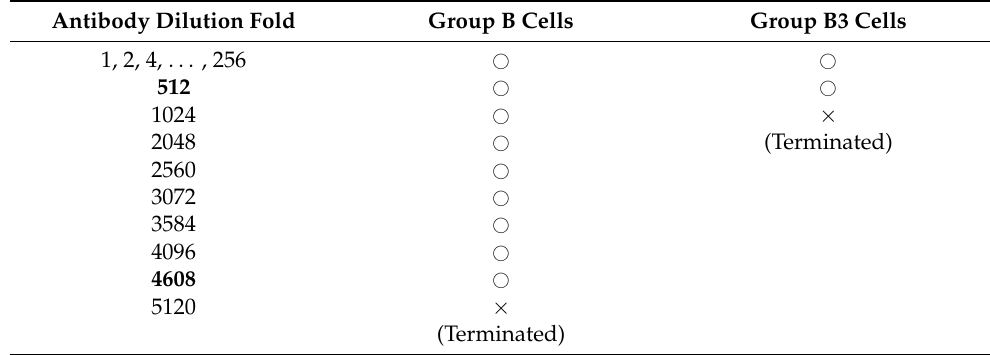
Table 2. Cell-tearing assays with a serial antibody dilution using maximum laser power (250 mW). Antibody Dilution